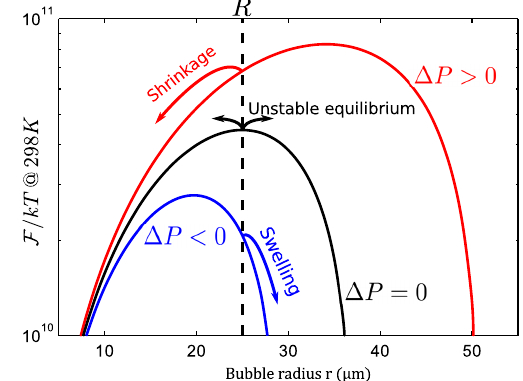
FIG. 2. Free energy of a single gas bubble of radius R in a weak gas-liquid solution. If Δ P ¼ 0 , the bubble radius is stationary. The bubble shrinks if Δ P > 0 and it swells if Δ P < 0 because of gas exchange between the liquid and the